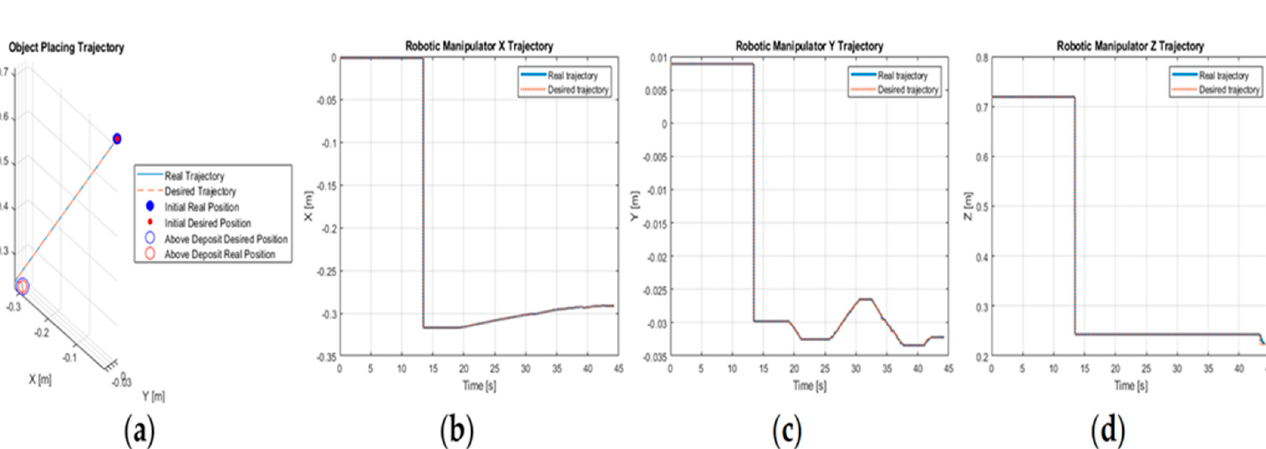
Figure 26. Tracking errors for RM Cyton picking object trajectory on: ( a ) X axis, ( b ), Y axis, ( c ) Z axis.